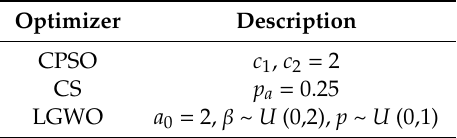
Table 3. The Chaos Particle Swarm Optimization (CPSO), Cuckoo Search (CS), and L é vy-embedded Grey Wolf Optimization (LGWO) algorithm parameter settings.